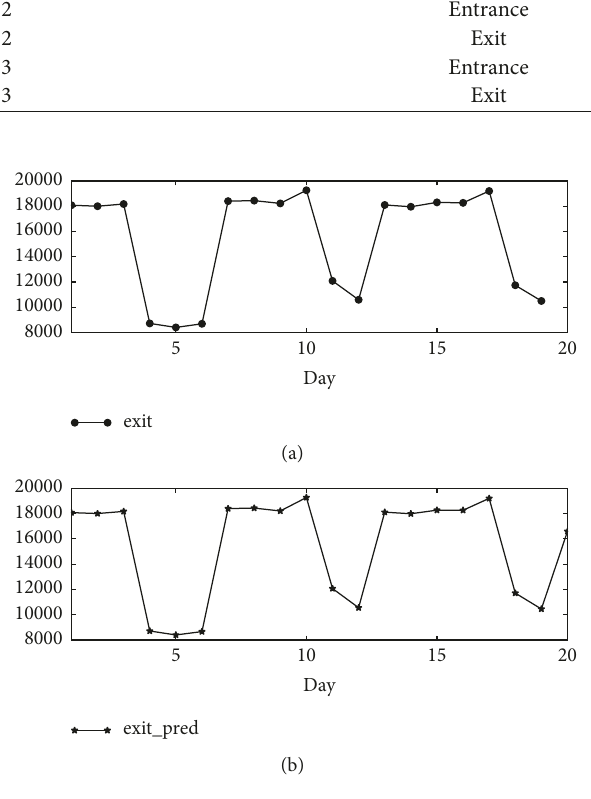
Figure 8: Prediction of daily exit passenger flow of Dabaishu rail transit station (3 hidden layers).